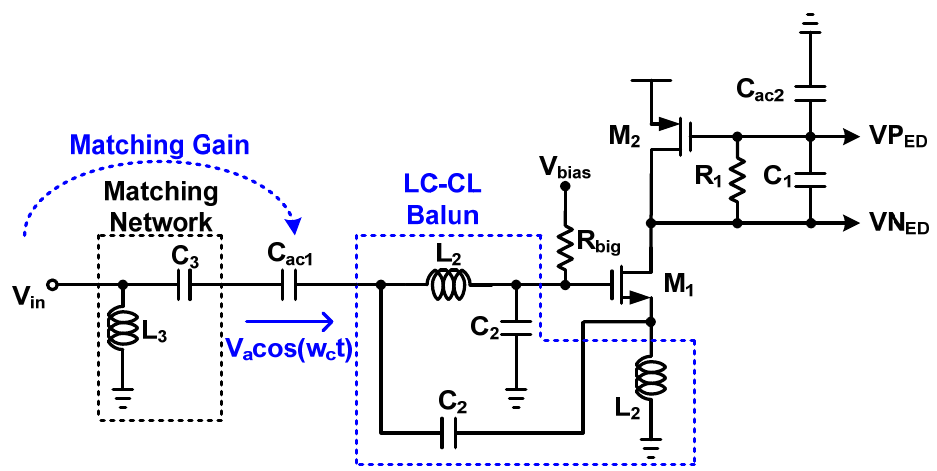
Figure 3. Proposed LC - CL balun-based Gm-boosting RF envelope detector.